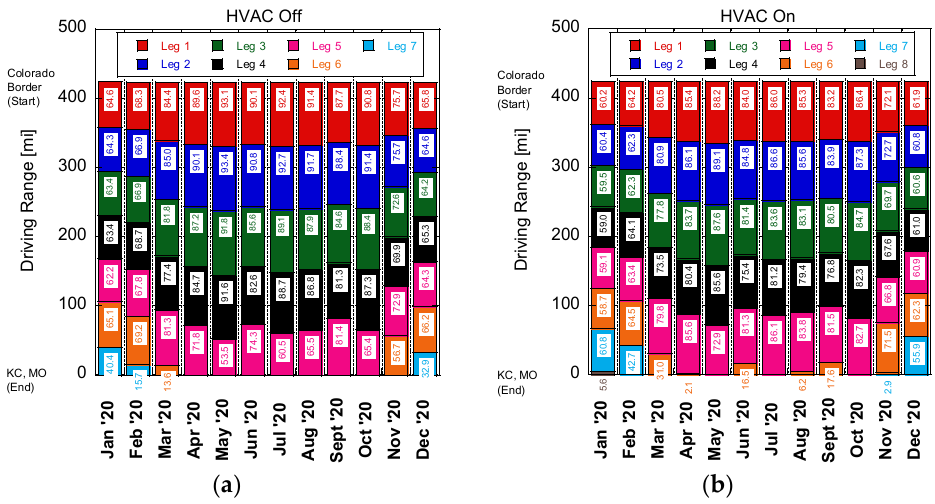
Figure 13. Traveling from the Colorado border to Kansas City, MO, on I-70 East with the ( a ) HVAC system off and ( b ) HVAC system on for the Nissan Leaf.